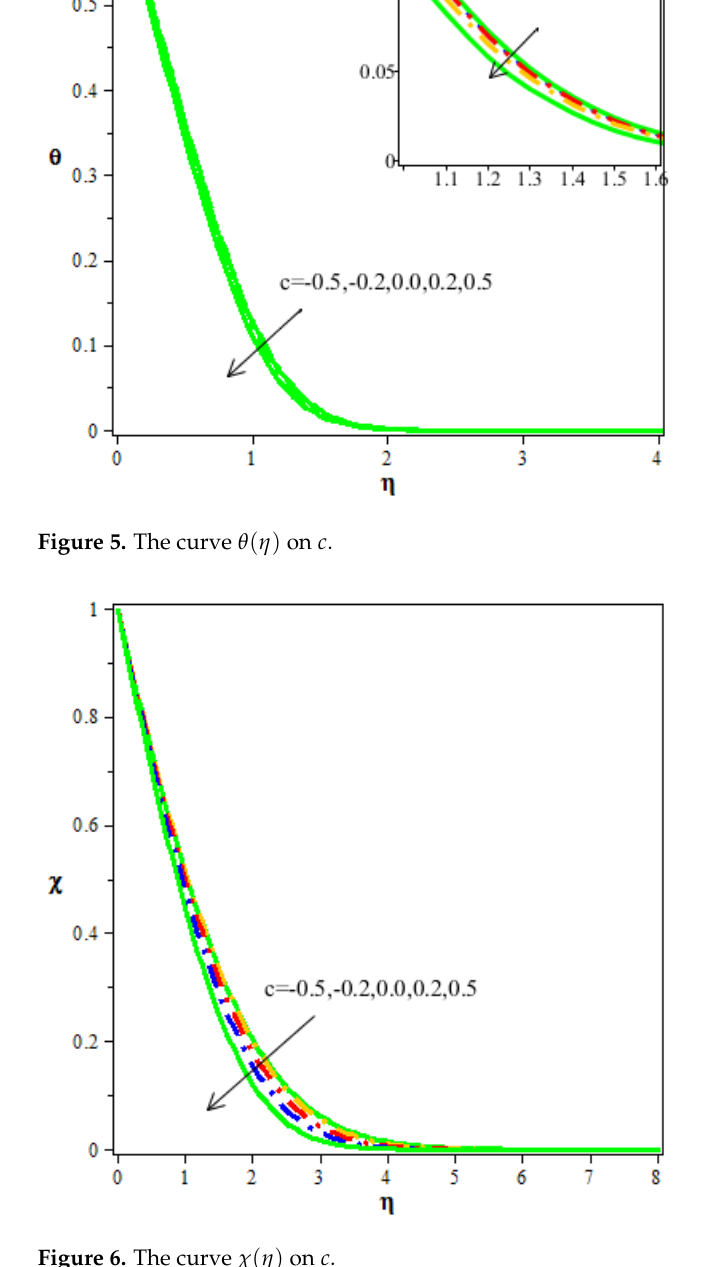
Figure 6. The curve χ ( η ) on c .